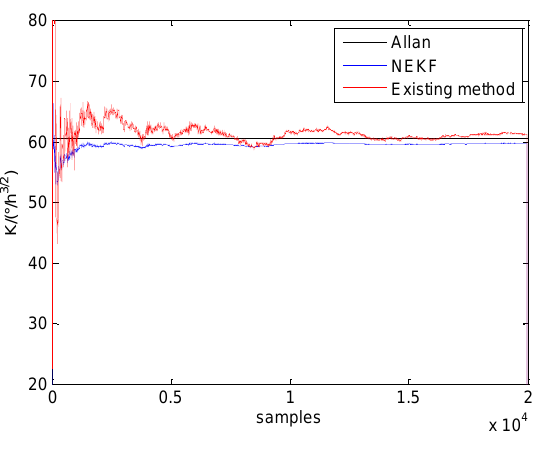
Figure 17. Estimates of K for Gyro Z.